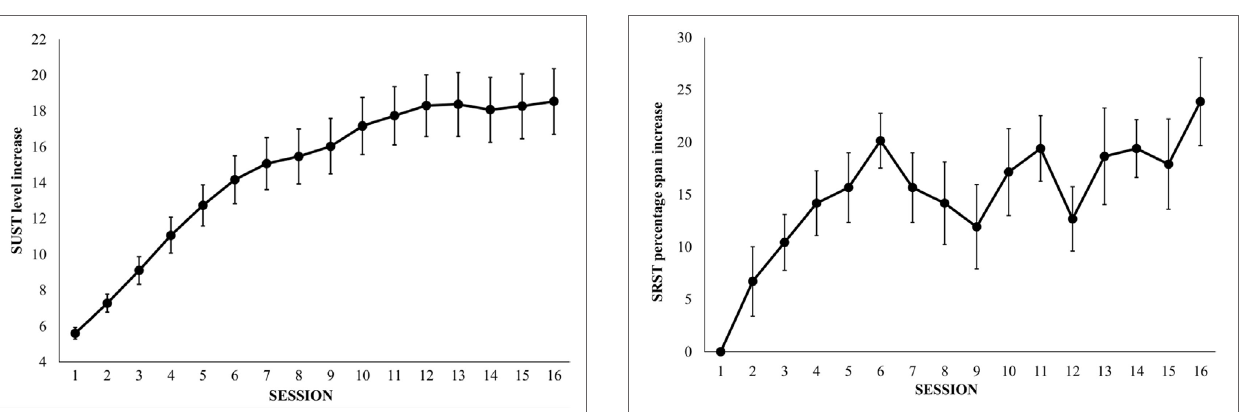
FigUre 3 | Percentage increases over 16 training sessions for the Reading span training task in the training group ( n = 31). Results are expressed as a percentage increase relative to performance on the first day of training.